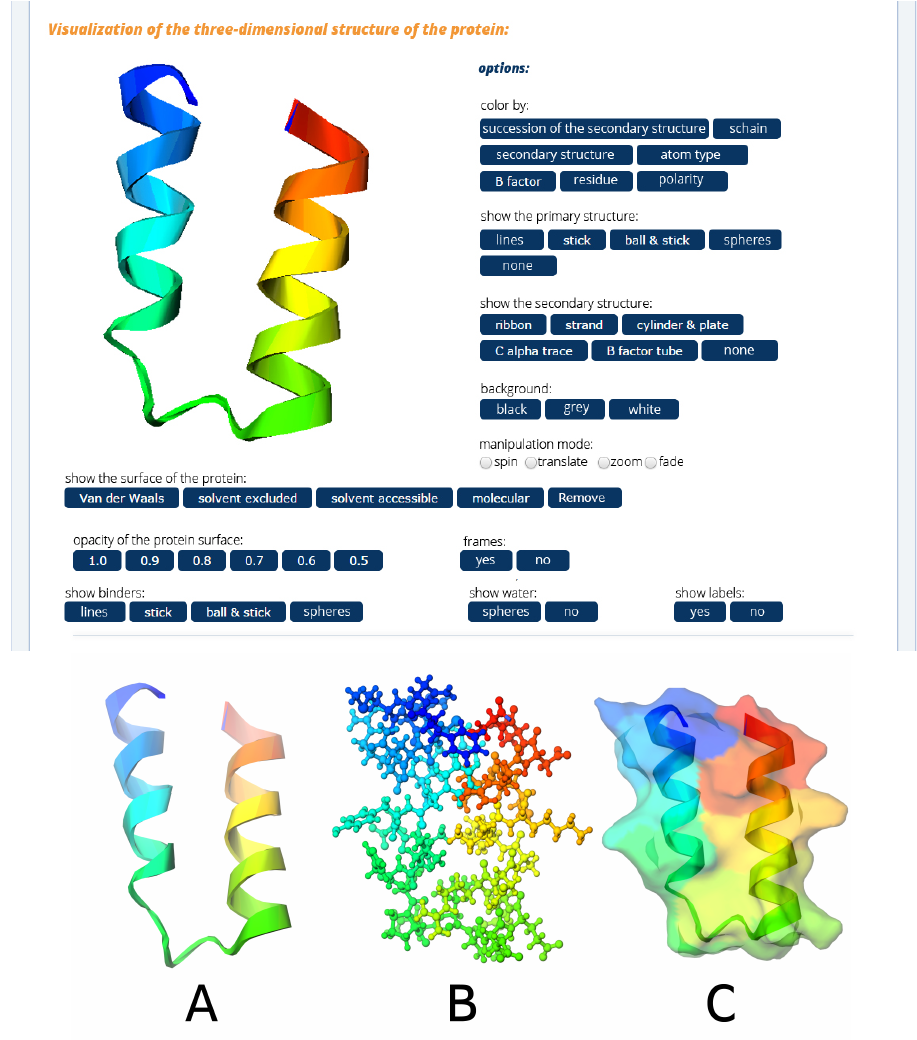
Figure 9. wCReF results page. 3D viewer. Here, we can see three different ways to view the 3D structure: ( A ) ribbon and colored by secondary structure succession; ( B ) ball and stick; ( C ) molecular